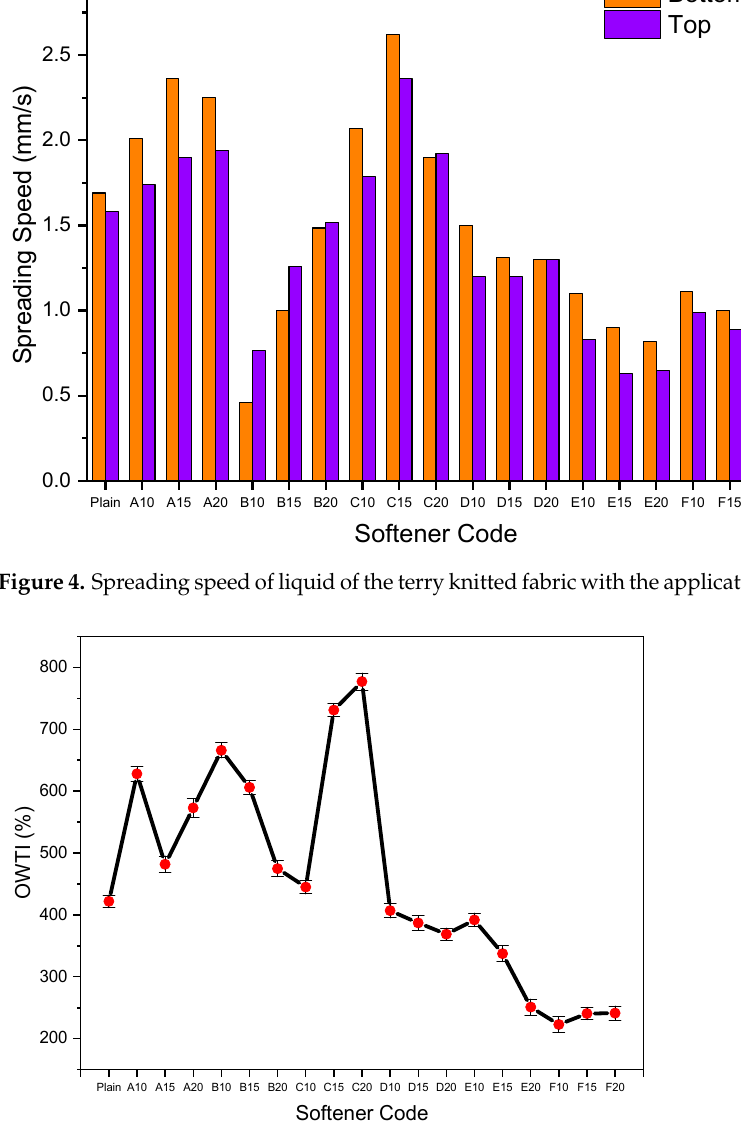
Figure 5. Accumulative one ‐ way transport capability.